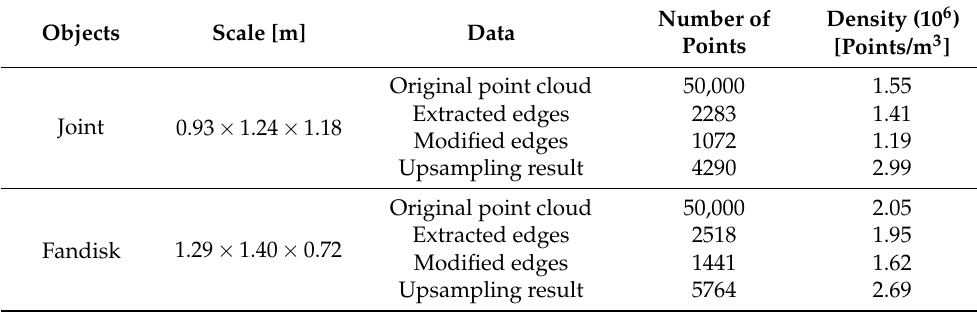
Table 1. The number of points and density of the Joint and Fandisk